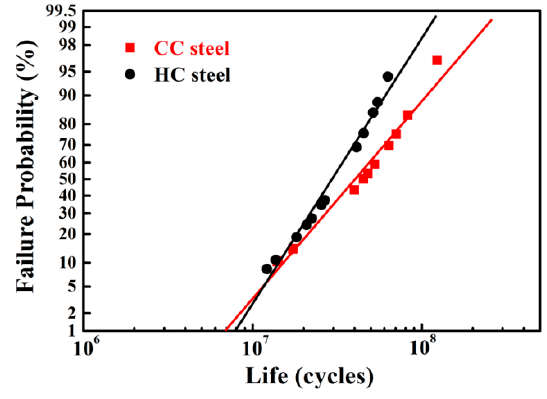
Figure 3. Weibull plots of RCF lives of CC and HC steels. Table 2. RCF lives of CC and HC steels.